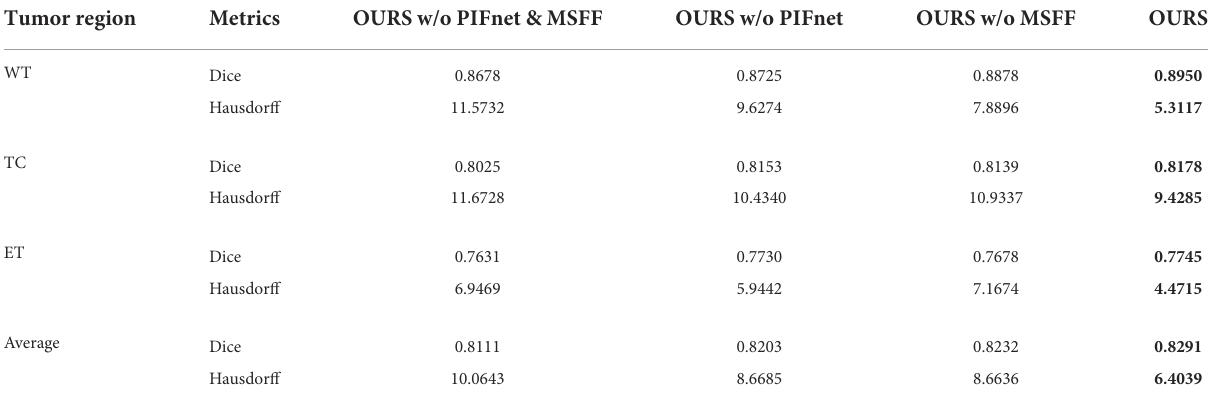
TABLE 3 Objective evaluation results for the ablation study of the proposed method on the BraTS 2020 validation sets. Tumor